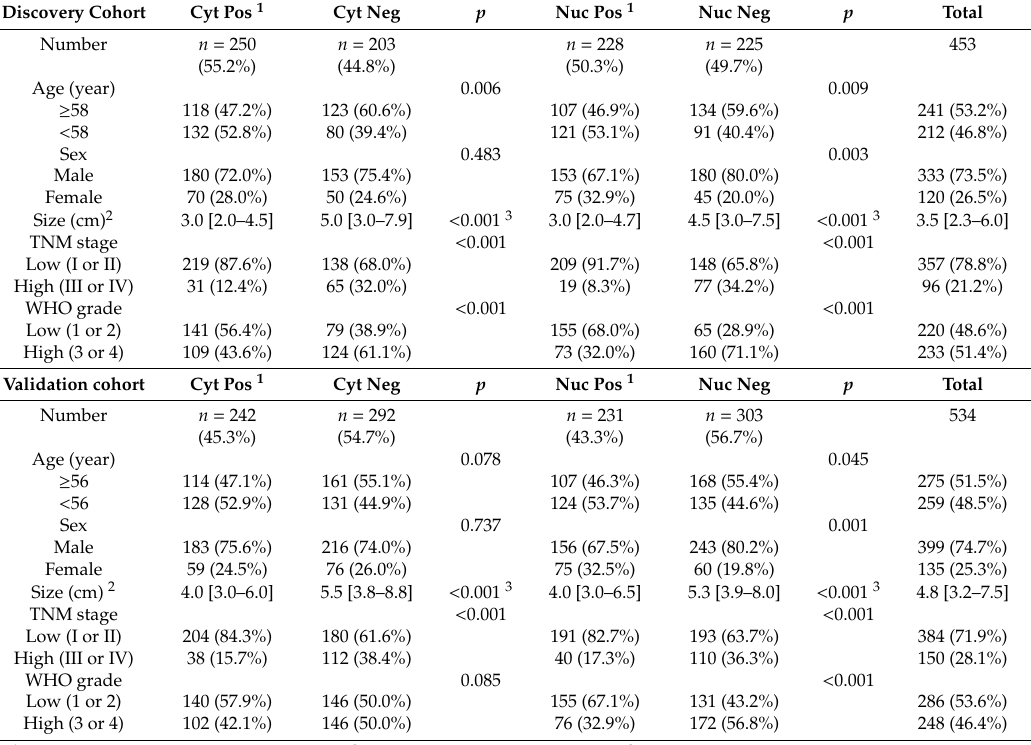
Table 1. pAMPK expression and clinicopathological details of the discovery and validation cohorts.